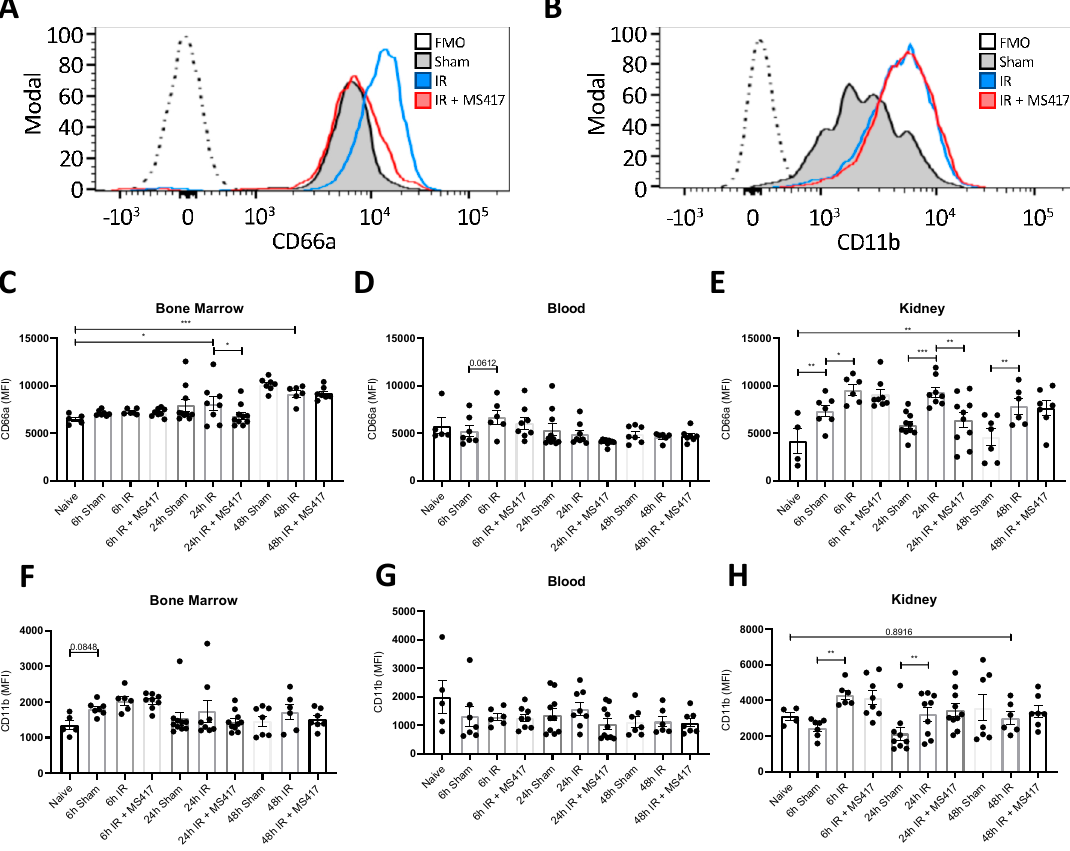
Figure 9. BRD4 inhibition attenuated CD66a up-regulation on kidney neutrophils following IRI but had no effect on CD11b expression. C57BL/6 mice were treated with 1 μ M MS417 daily for 7 days by oral gavage before unilateral IRI. ( A , B ) Representative histograms of CD66a and CD11b expression for kidney tissue neutrophils (CD16 high /side scatter area (SSC-A) high ) in mice comparing Sham and IRI plus/minus MS417 treatment at 24 h post-IRI. Bone marrow ( C , F ), blood ( D , G ) and kidney tissue ( E , H ) was collected at 6, 24, and 48 h following IRI and CD66a+ and CD11b+ neutrophils were quantified by flow cytometry. MFI = mean fluorescence intensity. ANOVA with Fischers LSD test was performed. n = 7–11, * p < 0.05, ** p < 0.01, *** p < 0.001.